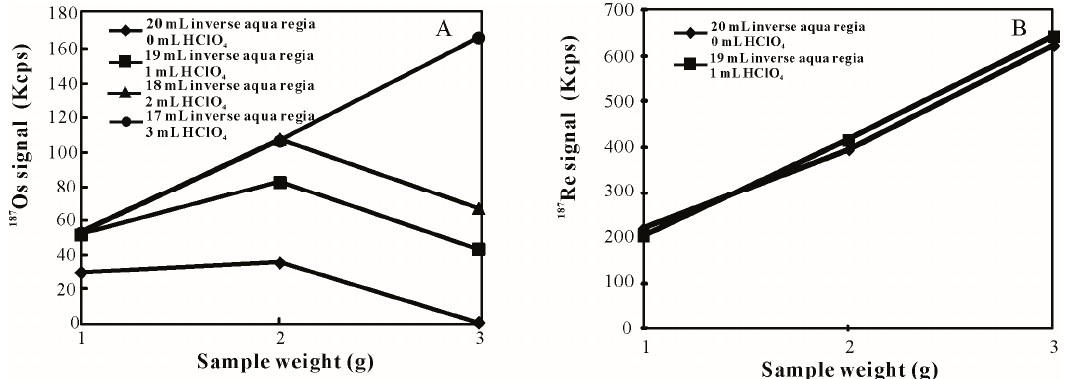
Figure 1. Os ( A ) and Re ( B ) signal for different masses of pyrite obtained using the inverse aqua regia and HClO4-inverse aqua regia methods.